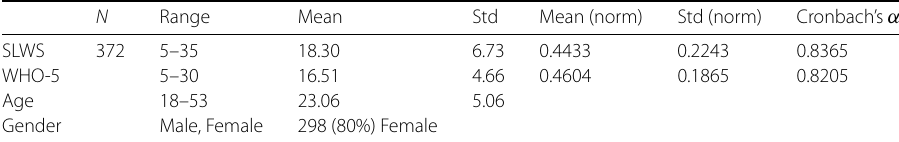
Table 2 Descriptive statistics for subjective well-being, age and gender in the final dataset N Range Mean